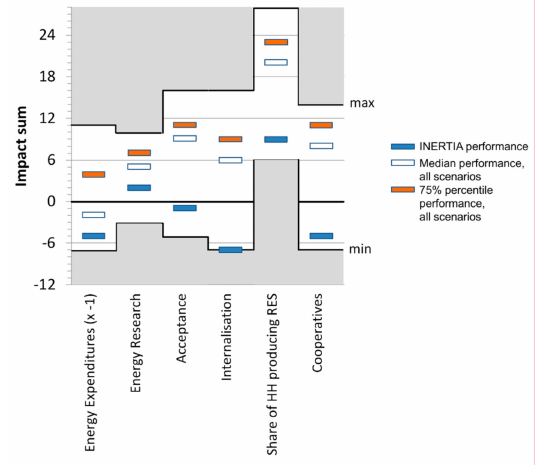
Figure 3. Impact sums of non-model-based indicators in scenario INERTIA compared to the 75%- percentile impact sum of the complete set of 4.869 Cross-Impact Balances (CIB)-scenarios. The borderlines mark the maximum and minimum impact sum values in the complete scenario